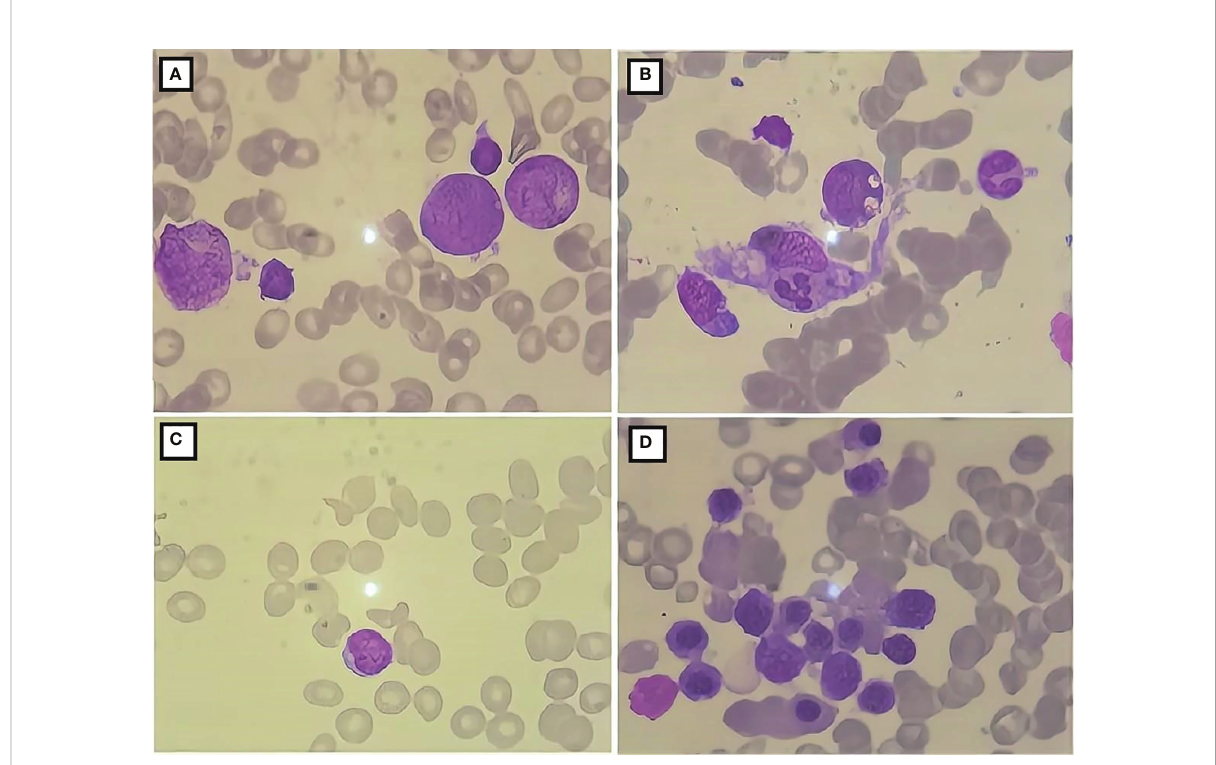
FIGURE 2 Bone marrow cell morphology of the patient. (A) The proliferation of bone marrow is active; (B) the presence of phagocytic cells; (C) severely diminished nucleated cell proliferation; (D) active bone marrow nucleated cell